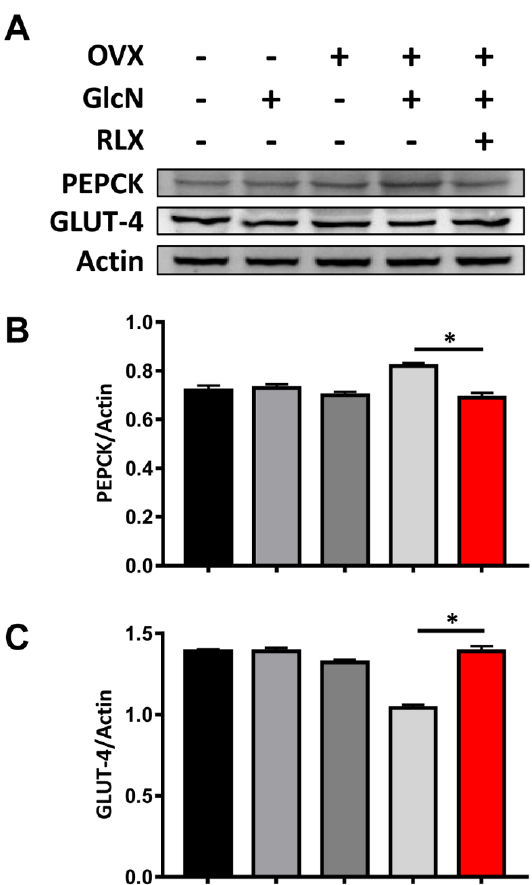
Figure 4. PEPCK expression in the liver and GLUT-4 expression in the skeletal muscle. The rats were randomly allocated to 5 treatments: (1) sham operation (Sham group), (2) sham with 750 mg/kg/d GlcN intraperitoneally (ip) injected for 14 days (Sham + GlcN group), (3) ovariec- tomy (OVX group), (4) ovariectomy with 750 mg/kg/d GlcN ip injected for 14 days (OVX+GlcN group), or (5) ovariectomy with 750 mg/kg/d GlcN ip injected for 14 days with subcutaneous RLX at 0.5 mg/kg/d. ( n = 8 in each group). ( A ) Increased PEPCK expression in the liver and decreased GLUT-4 expression in soleus muscle were only observed in OVX rats given GlcN. RLX treatment reversed these effects. ( B ) The OVX + GlcN group exhibited increased PEPCK expression. RLX significantly reduced PEPCK expression in OVX rats with GlcN treatment to nearly the same level as the Sham group. ( C ) The OVX + GlcN group demonstrated decreased GLUT-4 expression. RLX preserved the expression of GLUT-4 in OVX rats with GlcN, maintaining it at nearly the level of the Sham group. No significant difference was present in the PEPCK or GLUT-4 expression among the Sham + GlcN, OVX, Sham, and OVX + GlcN + RLX groups. * p <